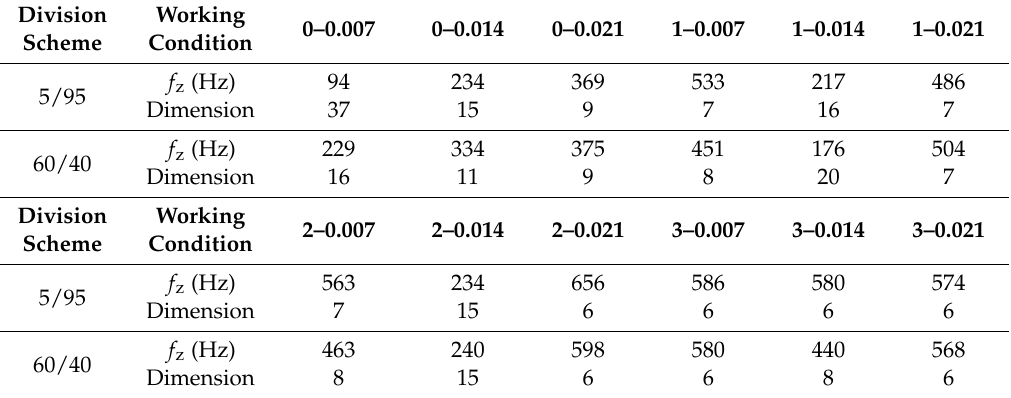
Table 2. Values of differential frequency and dimensions of character